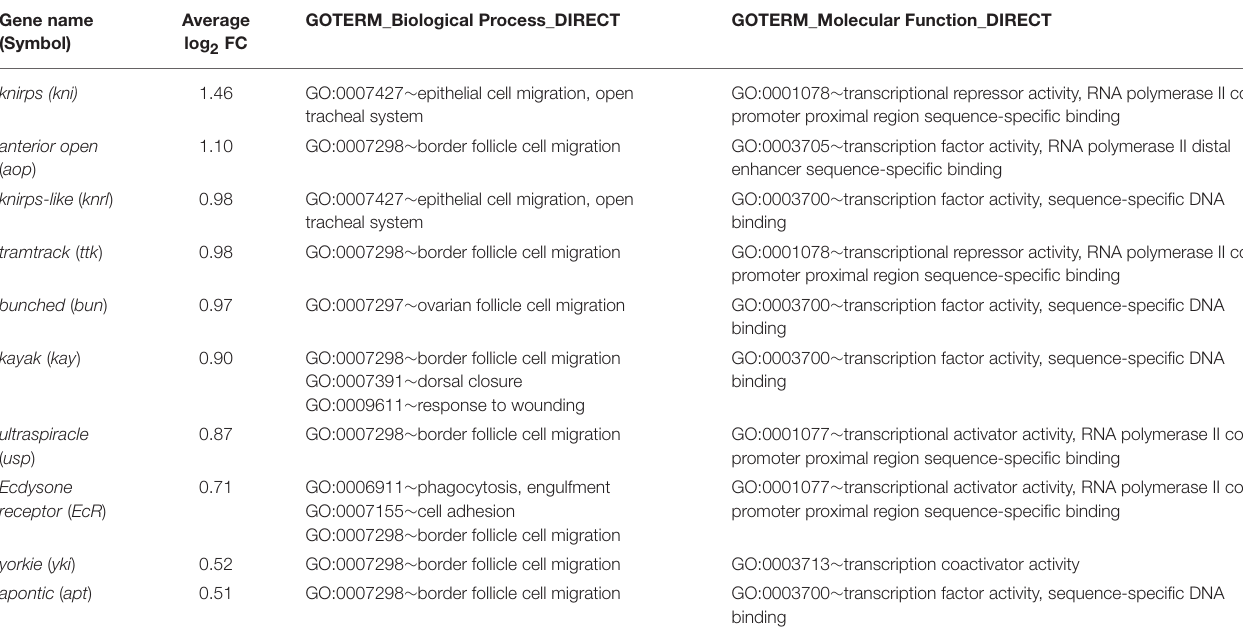
TABLE 2 | Transcription factors involved in cell